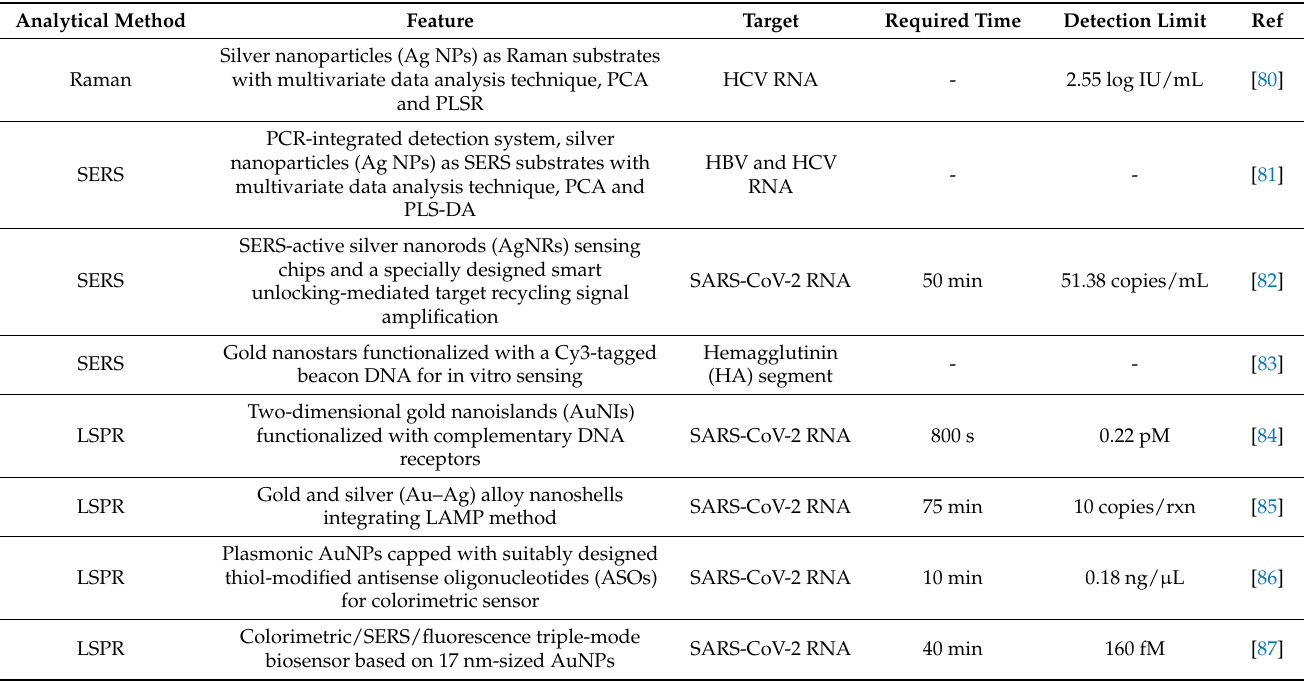
Table 4. Comparison of SERS and LSPR-based nanobiosensors for viral RNA detection. Analytical